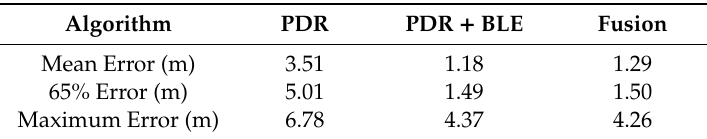
Table 4. Statistics of positioning errors.